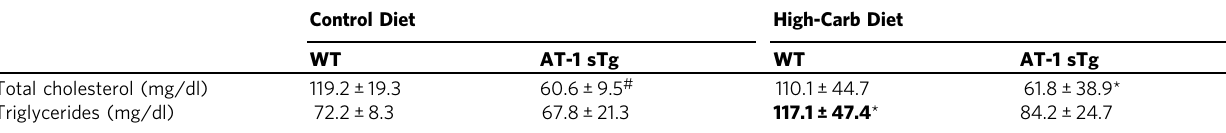
Table 4 Lipid serum pro fi le in WT and AT-1 sTg mice fed control and high-carb diet Control